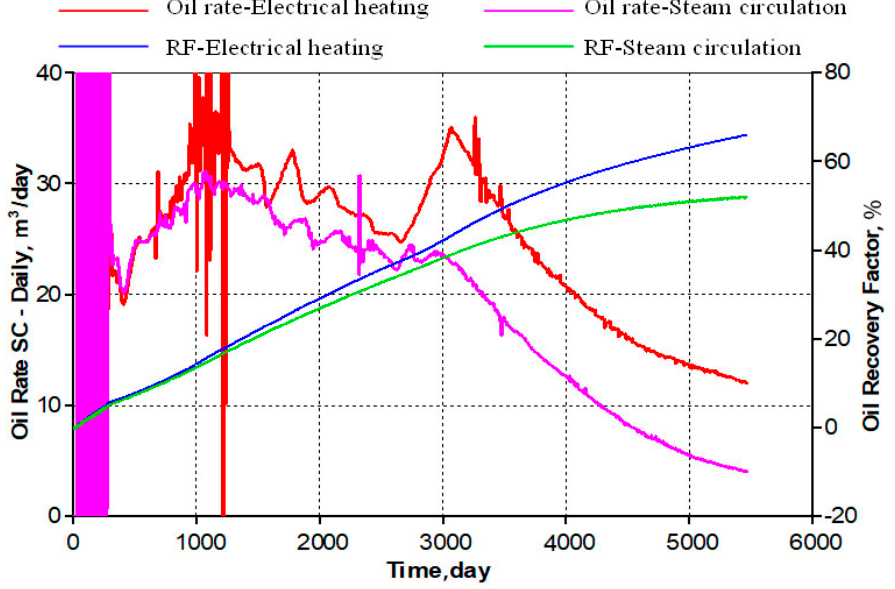
Figure 14. SAGD production performance comparison for cases with different preheating methods.